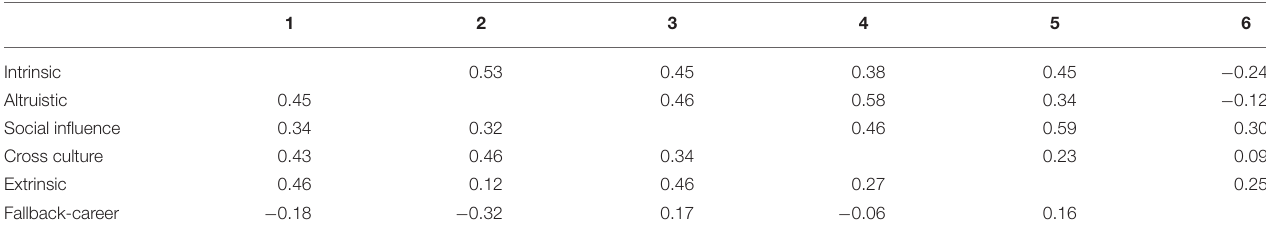
TABLE 3 | Correlation matrix between the extracted factors (native below and non-native